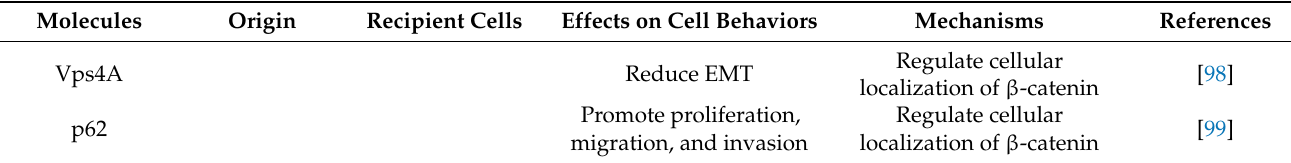
Table 3. EVs alter the cellular localization of β